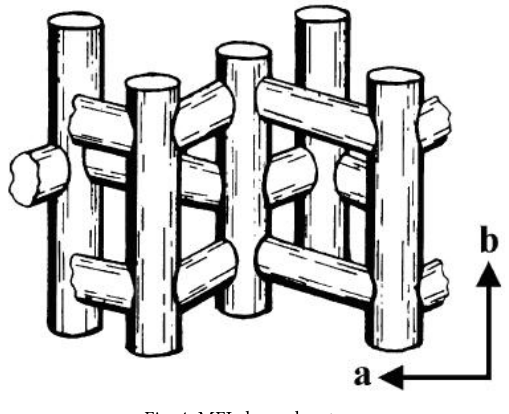
Fig. 4: MFI channel system